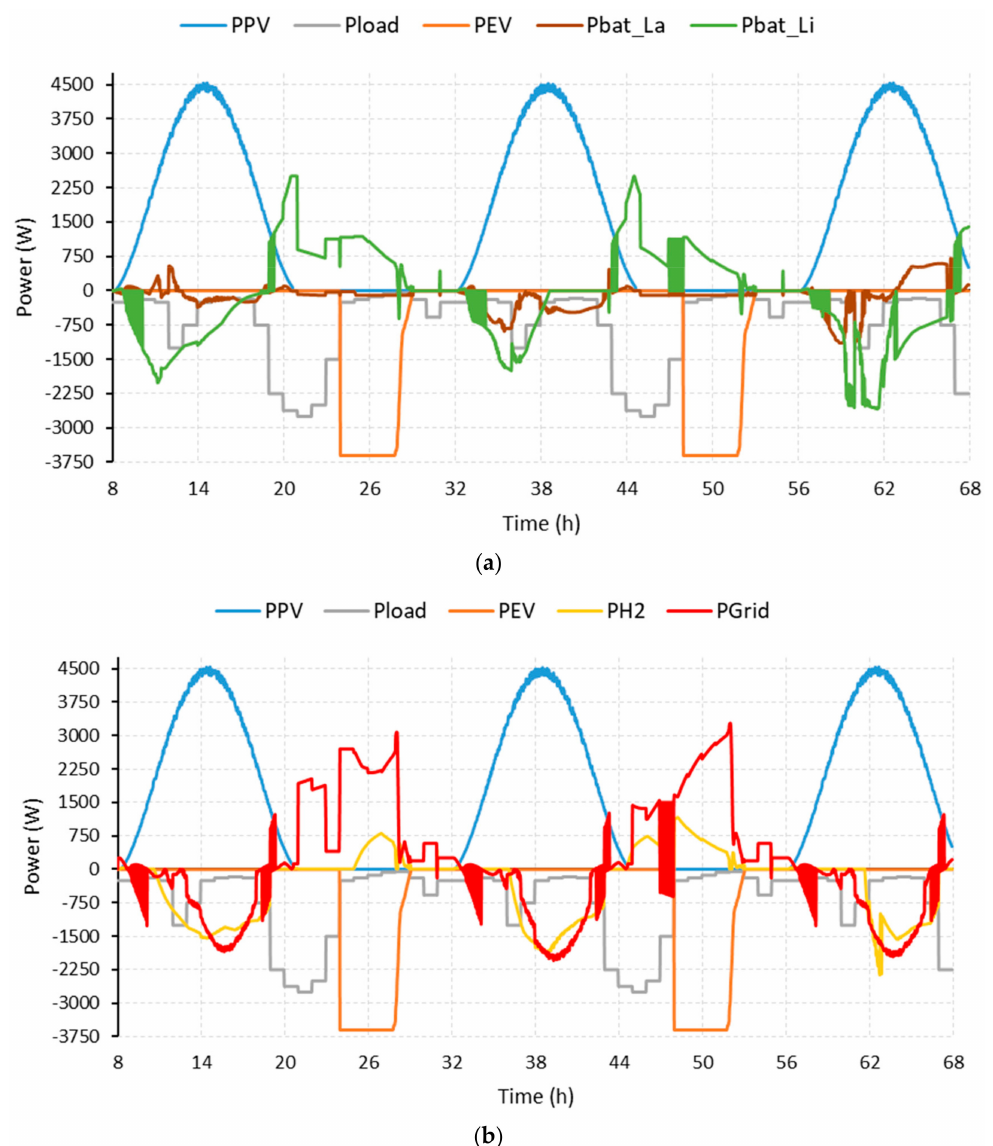
Figure 11. Microgrid power variables: ( a ) renewable (photovoltaic) power (PPV), residential consumption (Pload), electric vehicle consumption (PEV), lead-acid battery power (Pbat_La), and Li-ion battery power (Pbat_Li) for stable solar profile; ( b ) renewable (photovoltaic) power (PPV), residential consumption (Pload), electric vehicle consumption (PEV), hydrogen system power (PH2), and main power grid (PGrid) for stable solar